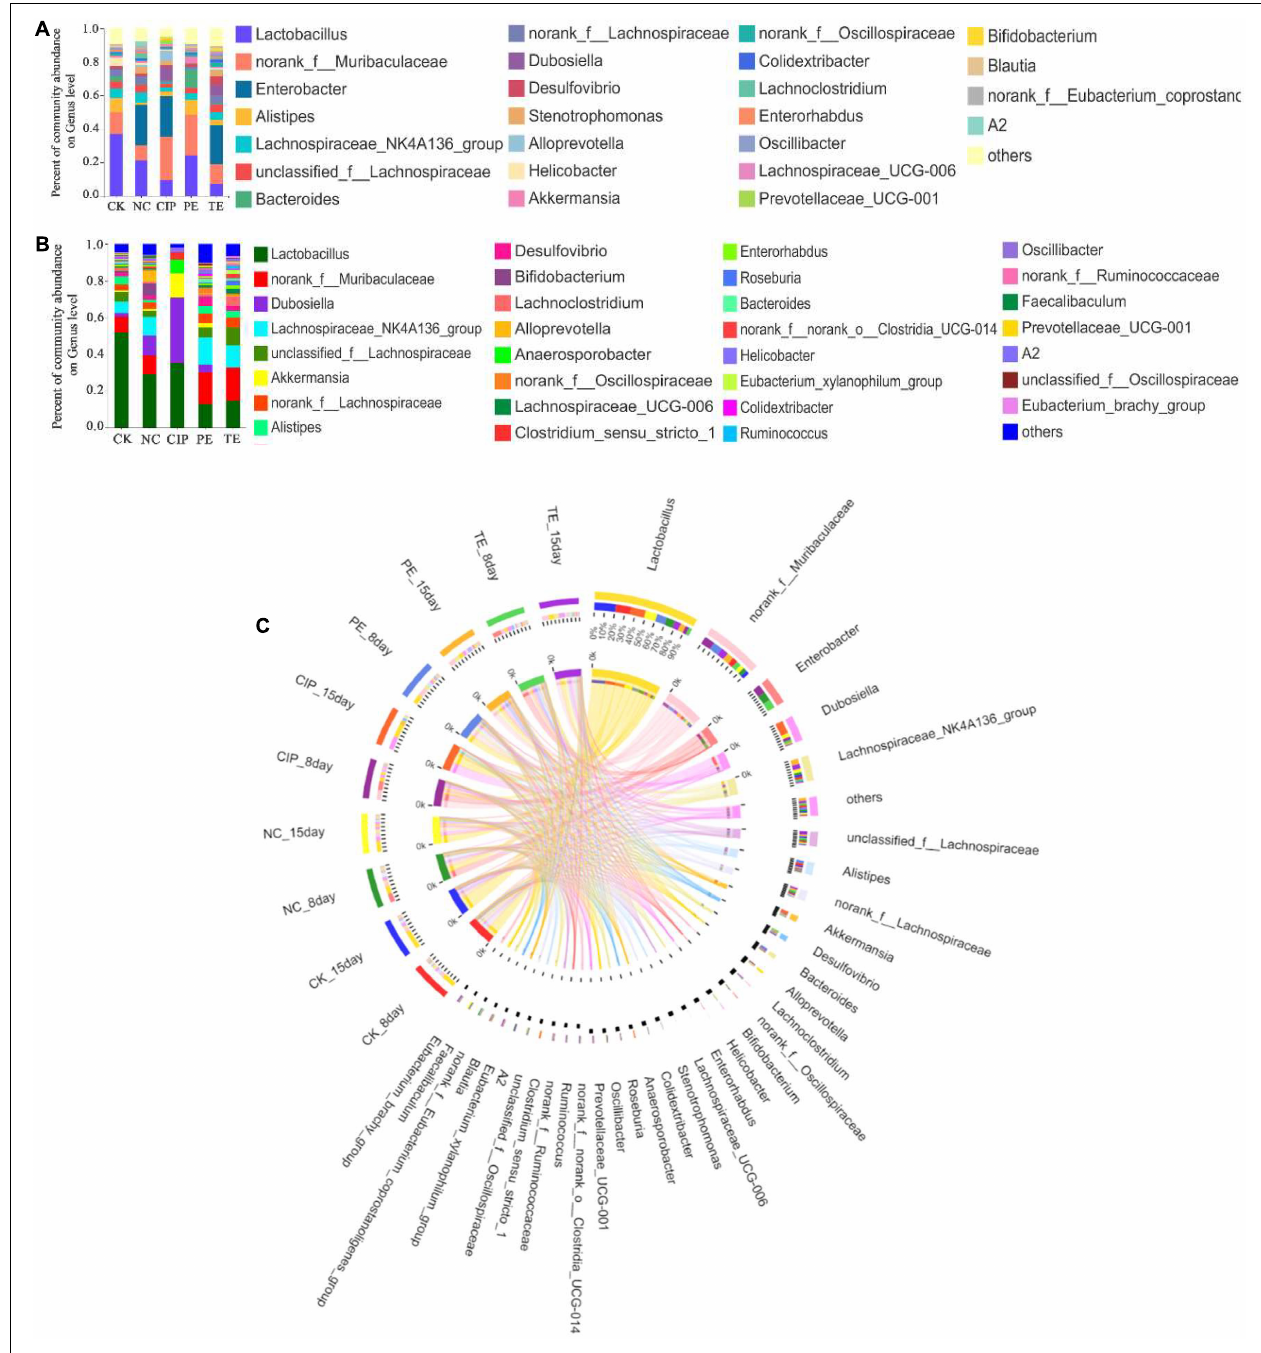
FIGURE 11 | Percent of community abundance on genus level. (A,B) Bar plots of the taxonomic composition at the genus on day 8 and 15. (C) Circus